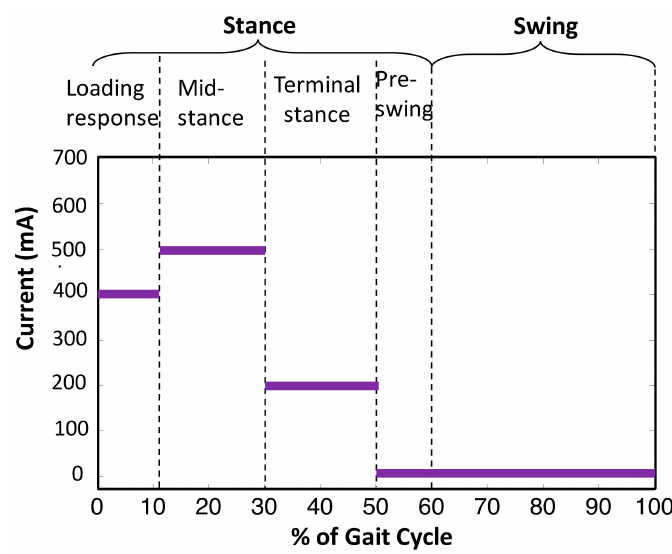
Figure 8. Final set of current references after